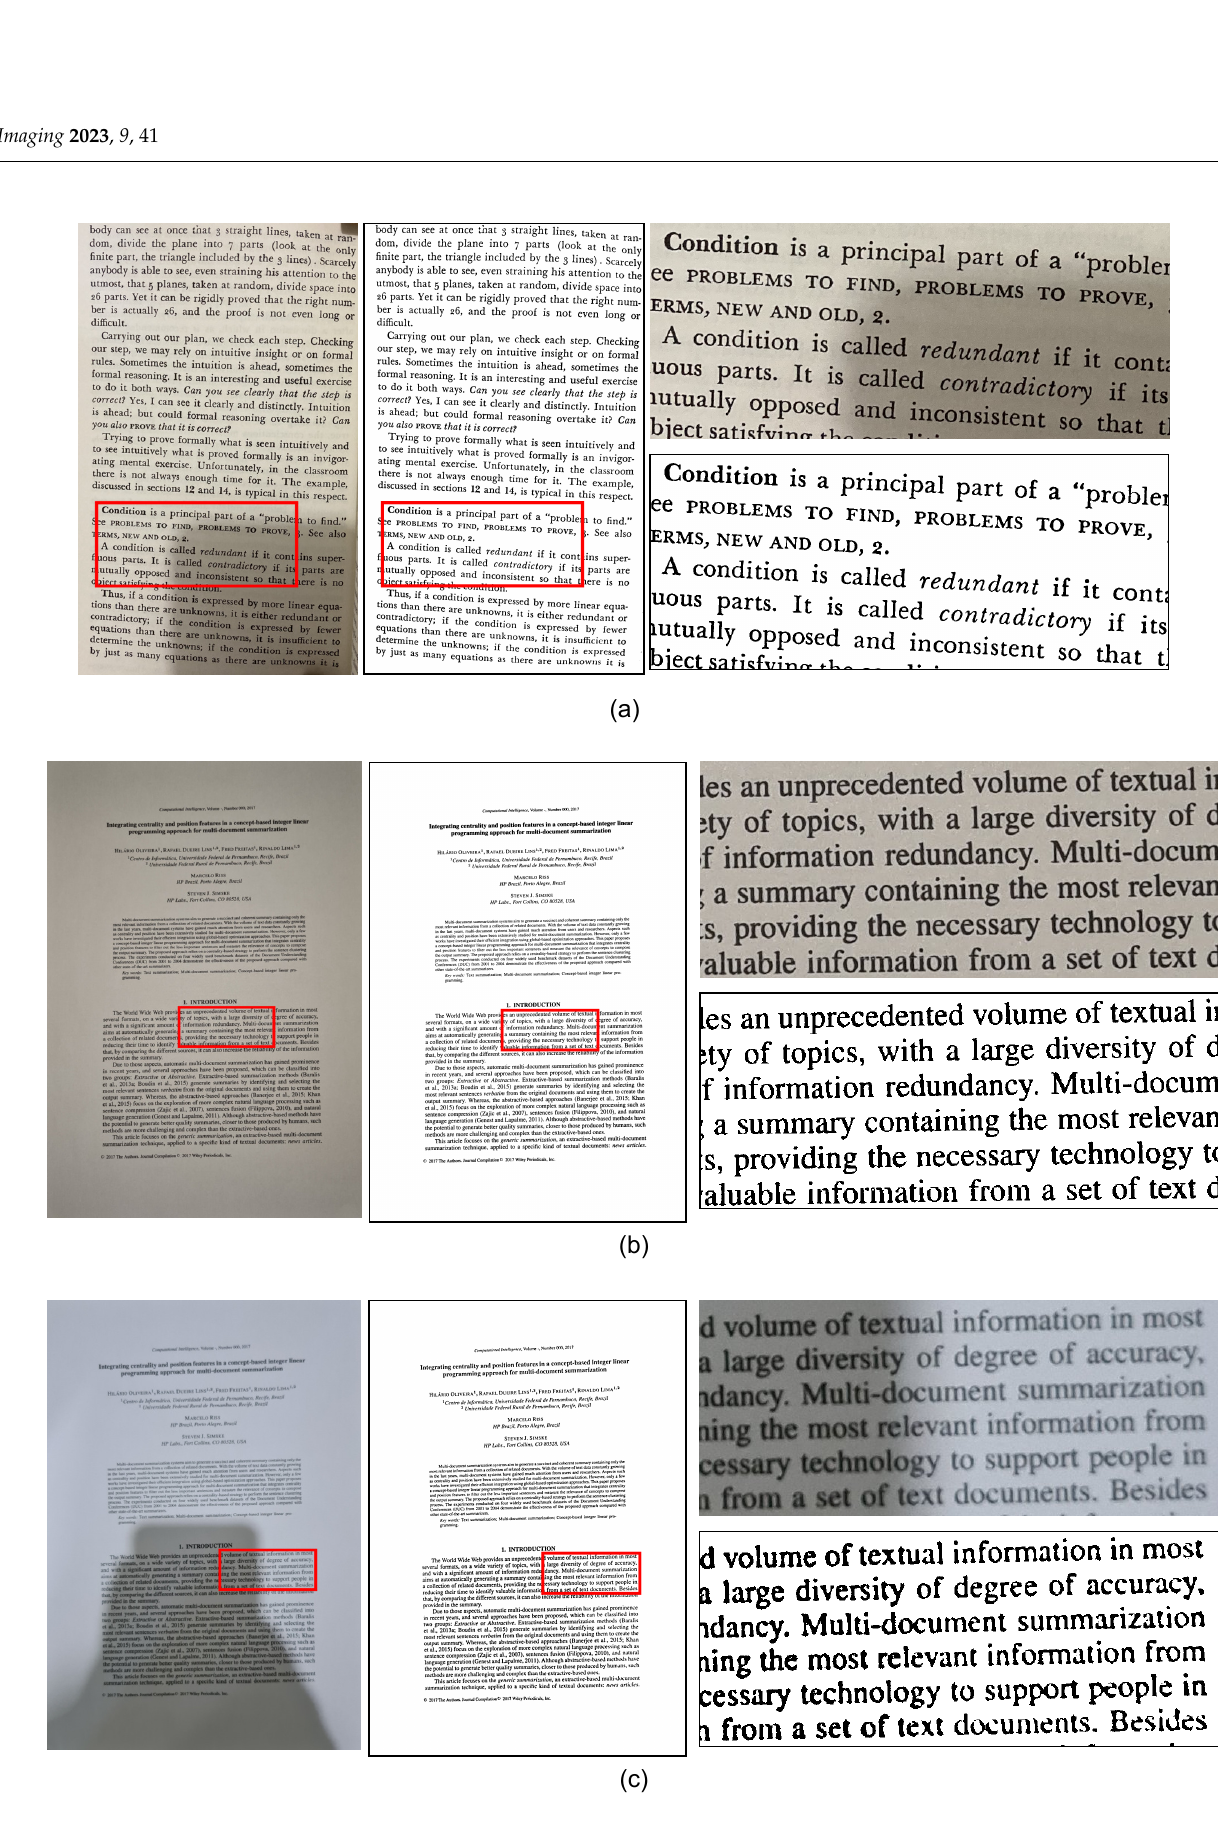
Figure 6. Dataset 2 example images. The red boxes indicates the crop region for the zoomed example next to each image. ( a ) Apple iPhone SE 2, book offset page, artificial light, flash off with medium shadow; ( b ) Samsung S20, deskjet printed, artificial light, medium shadow, flash off; ( c ) Same as ( b ), but with flash on, note that on deskjet printed pages no flash reflex interfere on the